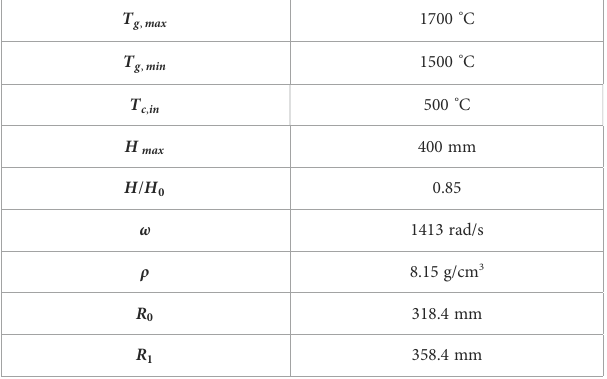
TABLE 1 Parameters used in the temperature fi eld model and the stress fi eld